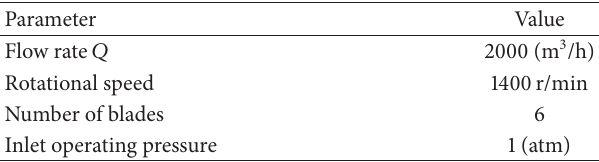
Table 3: Basic parameters for numerical